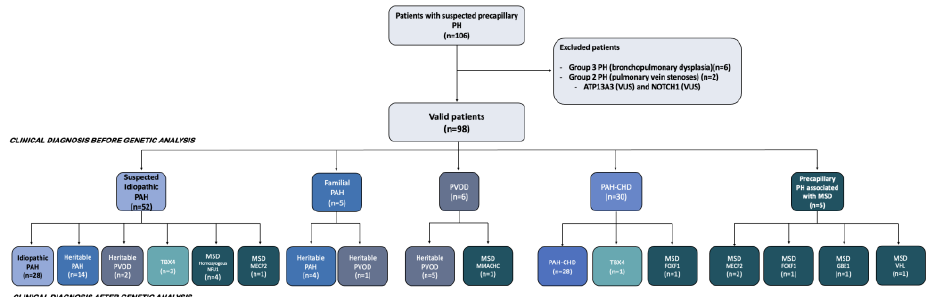
Figure 2. Flow-chart of included patients and the definitive diagnosis after genetic testing. Pa- tients in the REHIPED registry with genetic analysis and classified as a group 2 or group 3 pulmonary hypertension were excluded. FOXF1 (Forkhead Box F1 gene), GBE1 (1,4-Alpha-Glucan Branching Enzyme 1 gene), MECP2 (Methyl-CpG Binding Protein 2 gene), MMACHC (Methylmalonic aciduria and homocystinuria type C protein), MSD (multisystemic disorders), PAH (pulmonary arterial hypertension), PAH-CHD (pulmonary arterial hypertension associated with congenital heart disease), PH (pulmonary hypertension), PVOD (pulmonary veno-occlusive disease), TBX4 (T-Box Transcription Factor 4), VUS (variant of unknown significance), VHL (Von-Hippel-Lindau gene).